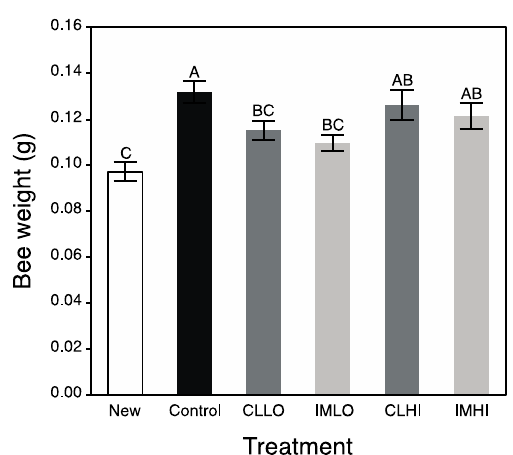
Table 2. Results from separate statistical tests of experimental treatments on energetic and nutrient substrate content of individual honey bees after two weeks.